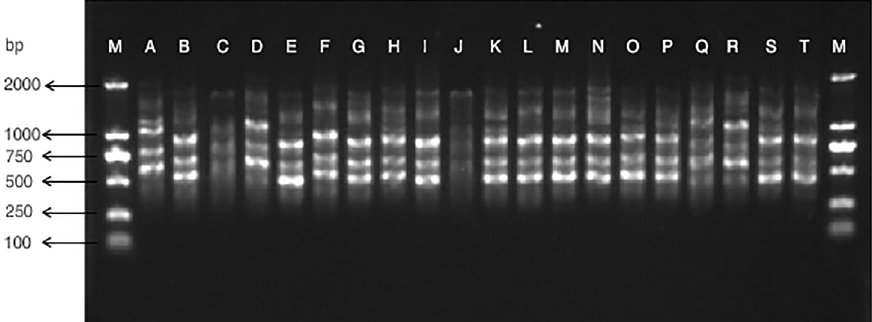
Fig 2 . Amplification products of the primer IS16 for analyzed populations (A to T). M in the lane 1